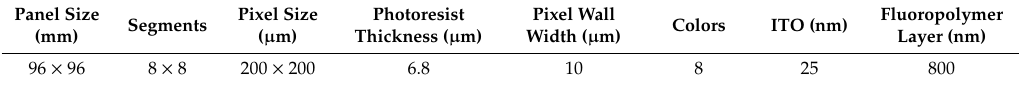
Figure 2. A three-layer colorful segmented electrowetting display design. ( a ) Side view of three-layer architecture pixels with the principle of subtractive color mixing in a reflective display. ( b ) Top view of the segmented electrowetting display arrays and details of pixel design, with the square pixel grid and notch-patterned indium tin oxide (ITO) electrode. Table 1. Design parameters of a colorful segmented electrowetting display